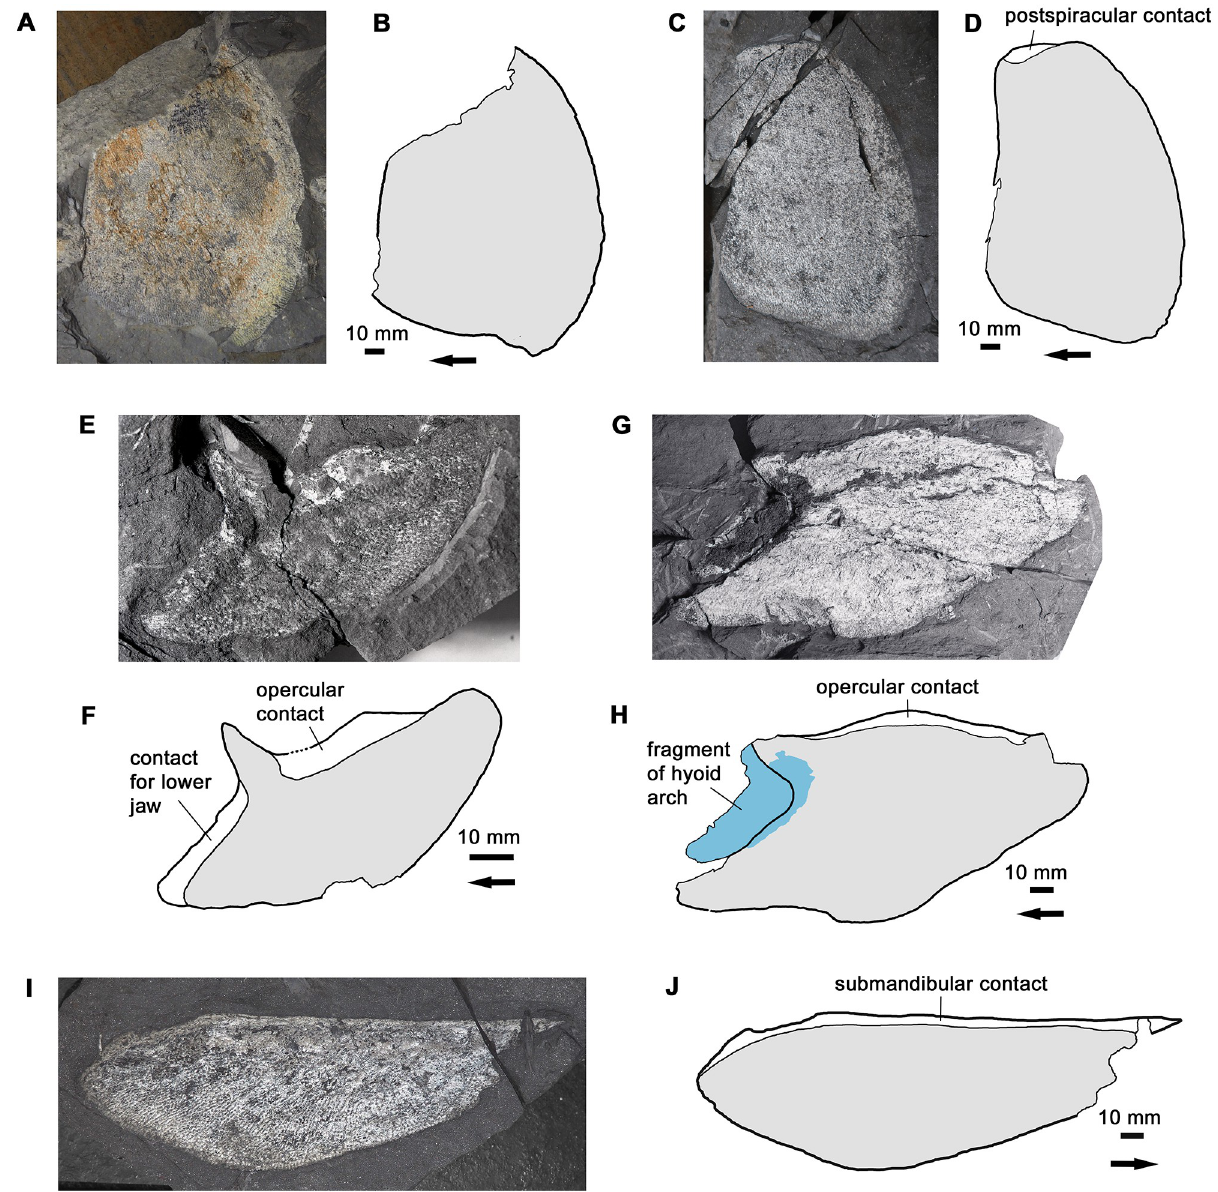
Fig 8. The gill cover. A-B, photo and interpretative drawing of opercular AM5532. C-D, photo and interpretative drawing of opercular AM6521a. E-F, photo and interpretative drawing of subopercular AM5249. G-H, photo and interpretative drawing of subopercular AM5391bi. I-J, photo and interpretative drawing of gular AM5888. Graphic conventions as in Fig 4. In H, blue indicates a partially preserved hyoid arch element adhering to the subopercular.